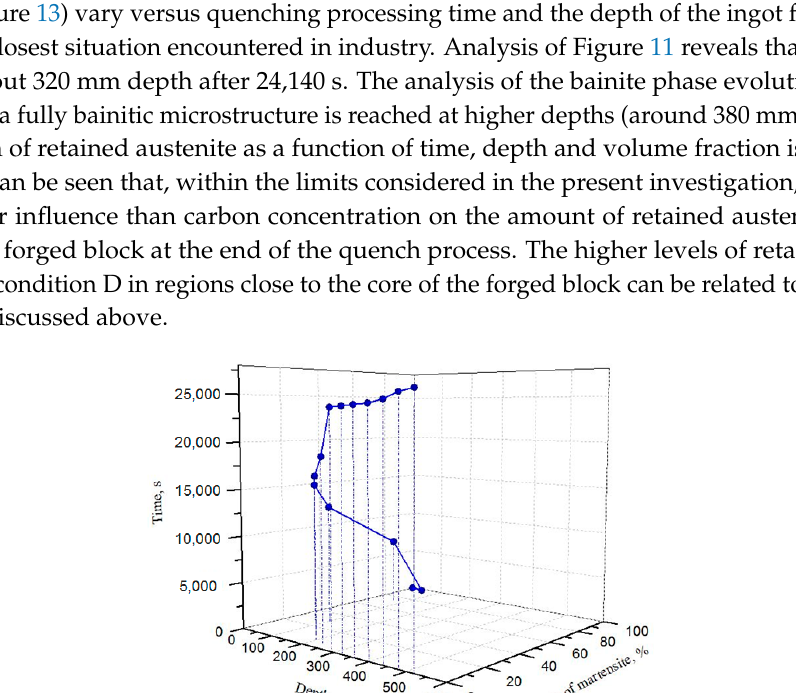
Figure 12. Calculated bainite distribution of condition (D). Figure 13. Calculated retained austenite distribution of condition (D).